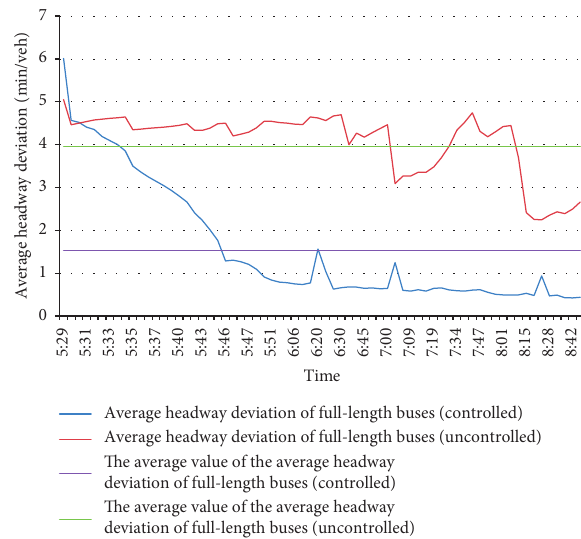
The average value of the average headway deviation of full-length buses (uncontrolled) Figure 7: Variation trend of average headway deviation under controlled and uncontrolled conditions.